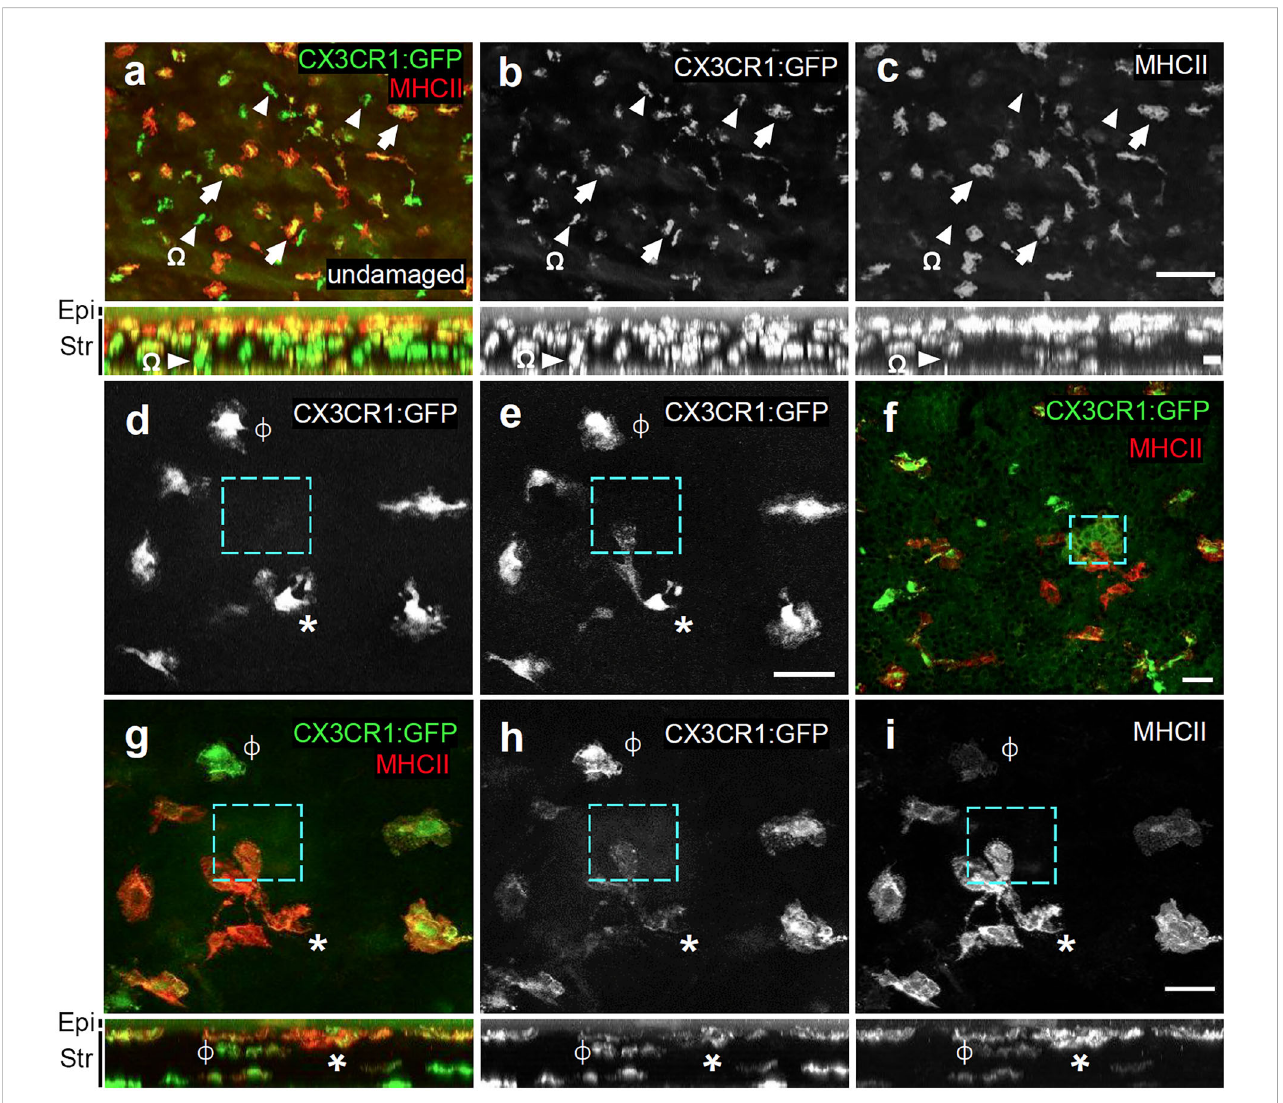
FIGURE 7 Responding cells co-label with MHCII. (A – C) Flat-mount of a PFA- fi xed undamaged Cx3cr1 GFP/+ cornea immunolabelled for MHC class II (red) and GFP. Not all GFP+ cells are MHCII+ (arrows indicate GFP+MHCII+ double-positive cells; arrowheads = GFP+ only). Strati fi cation of MHCII+ cells toward apical region of the stroma is observed. (D, E) Live imaging of Cx3cr1 :GFP+ macrophages before (D) , and 70 ’ after microdamage (E) . The cyan dashed box represents the region of microdamage. “ * ” marks a macrophage that has become polarized and has extended a pseudopod-like process toward the region of damage. f marks a non-responding macrophage. (F – I) Immunolabeling of the cornea from (E) that was fi xed in 4% PFA and labelled for MHC class II+ (red) and GFP. In (G – I) , f and * indicate the same cells as in (D, E) . The panels directly below (A – C) and (G – I) represent their corresponding X-Z projections. Epi, epithelium; Str, stroma. Cyan box = microdamaged area. The responding cell (*) co-labels with MHCII. Scale bars represents 100 m m (A – C) 30 m m (D – I)